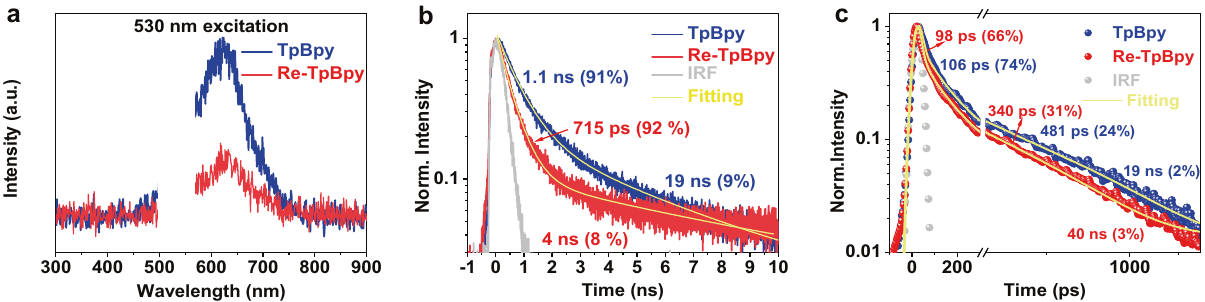
Fig. 4 Steady-state and time-resolved PL spectroscopy measurement. ( a ) Steady-state PL emission spectra of TpBpy and Re-TpBpy normalized according to the absorbance at the excitation wavelength. ( b ) PL decays measured in TCSPC of the TpBpy and Re-TpBpy. Excitation wavelength = 438 nm. ( c ) PL decays of the TpBpy and Re-TpBpy measured with streak camera excited at 400 nm. Source data are provided as a Source data fi le.